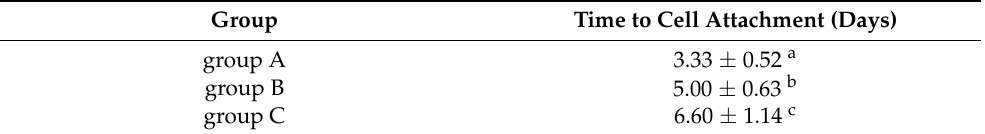
Figure 1. The time required for cell adhesion was observed among the three groups. The time required for cell adhesion was prolonged with aging in the three groups. Table 2. Comparison of time required for cell attachment among